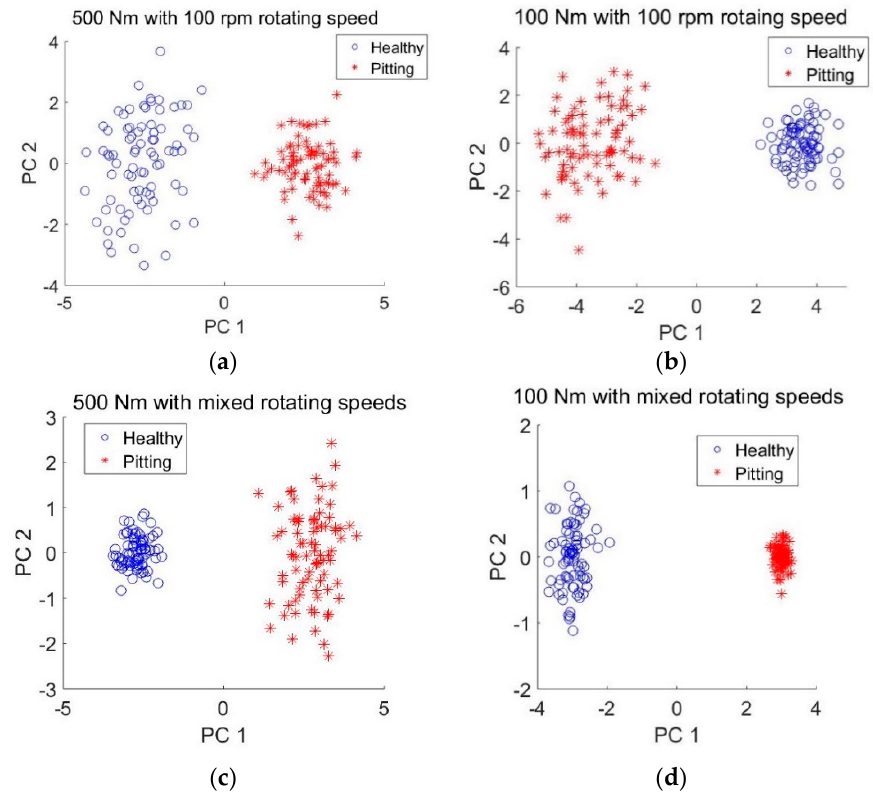
Figure 10. Scatter plot of principle components for the features extracted from: ( a ) dataset A; ( b ) dataset B; ( c ) dataset E, and ( d ) dataset F.